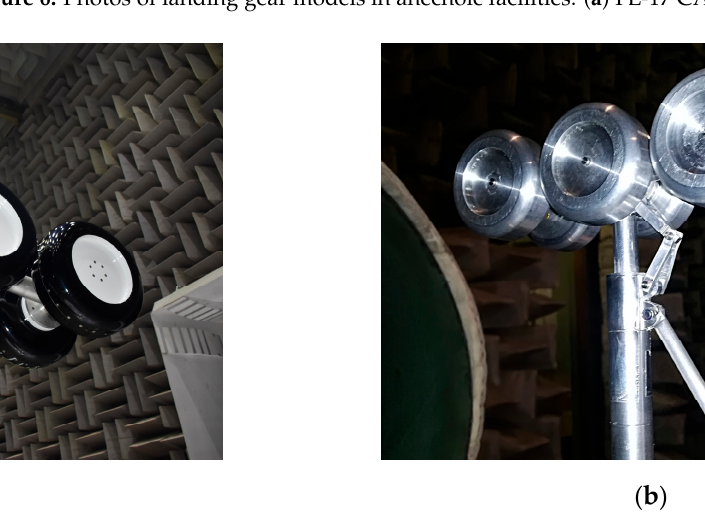
Figure 6. Photos of landing gear models in anechoic facilities: ( a ) FL-17 CARDC; ( b ) AC-2 TsAGI.